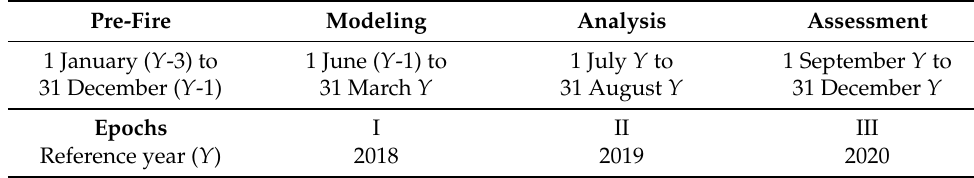
Figure 4. The median images obtained from the period: 1 January 2017 to 31 December 2019 for Areas 1 ( left ) and 2 ( right ). Representations in natural color composition and computed from images acquired by the Landsat-8 OLI sensor. Table 1. Epochs and respective periods, expressed in terms of the reference year Y